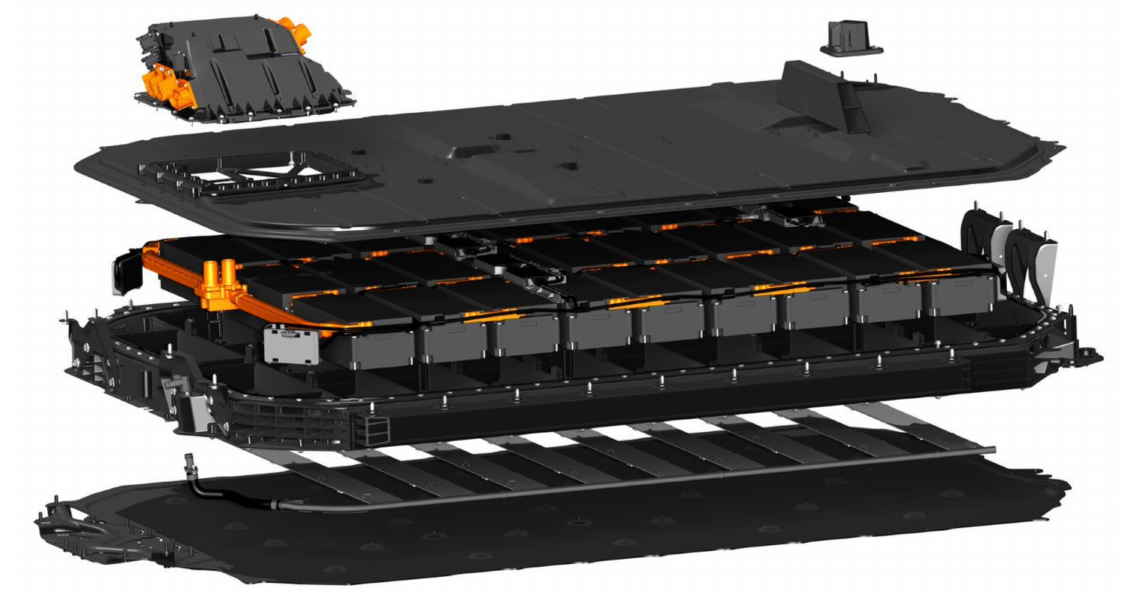
Figure 1. The battery pack and battery module disposition